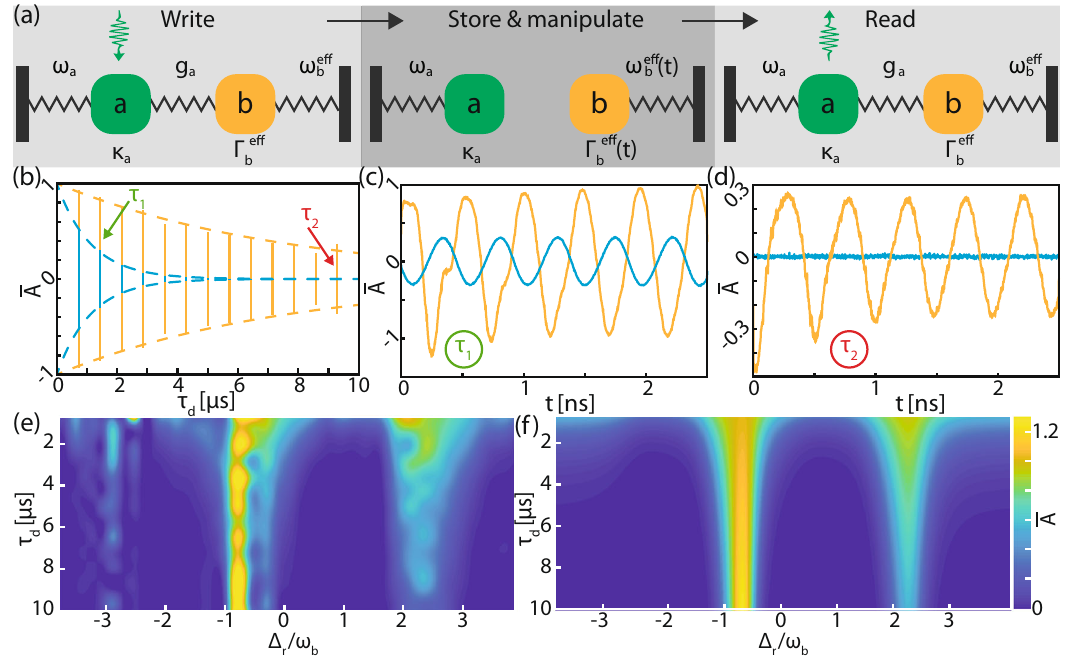
Fig. 3 Enhancing the optomechanical pulse-storage time. a Outline of the storage protocol where the optomechanical coupling between optical mode a and the mechanical mode facilitates storage of an optical pulse as a mechanical excitation. Mode r is used to manipulate the mechanical damping rate, Γ eff (t), and frequency, ω eff (t) which can be carried out concurrently with the storage process. b Normalized read pulse amplitude, (cid:2) A for the off-resonant, b b Δ ≫ ω Δ ω τ fi t to an exponential decay (dashed lines) to extract Γ eff r m , case (cyan) and for r ~ m (orange) as a function of d . These are read data shown in ( b ) for τ d = (0.14, 0.93) μ s, illustrating the enhancement in (cid:2) A when Δ r ~ ω m . e Complete data set from which ( b ) was taken showing both an enhancement and reduction in storage time as a function of Δ r , which is compared to the expected behavior ( f